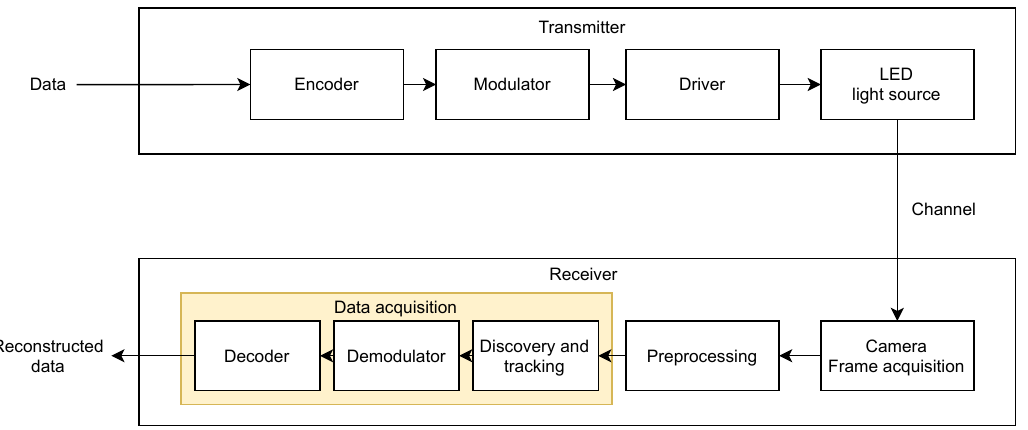
Figure 1. Diagram of an OCC